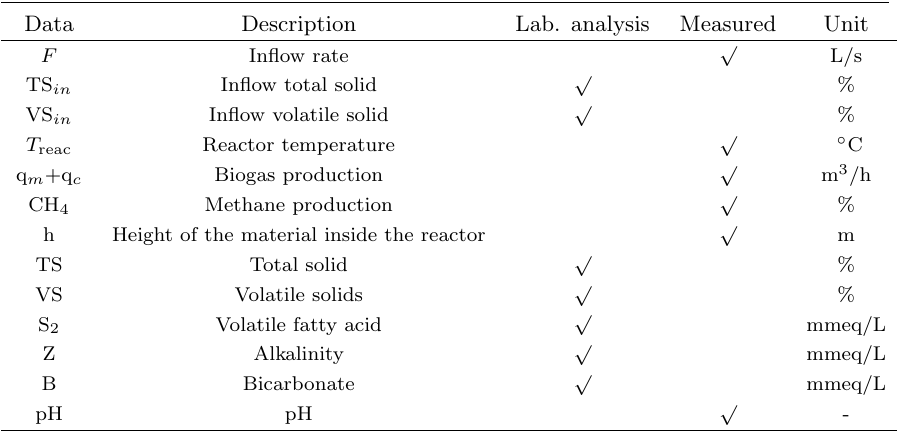
Table 1: Experimental data from VEAS